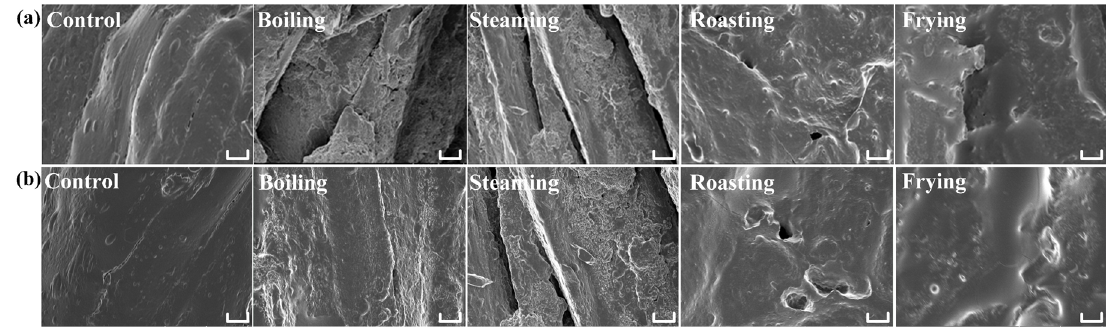
Figure 6. Cryo-scanning electron microscopy (cryo-SEM) images of microstructures of fish samples after boiling, steaming, roasting and Figure 600. b, × 1000). Control is the fish sample without heating treatment. Scale bar = 20 μm.